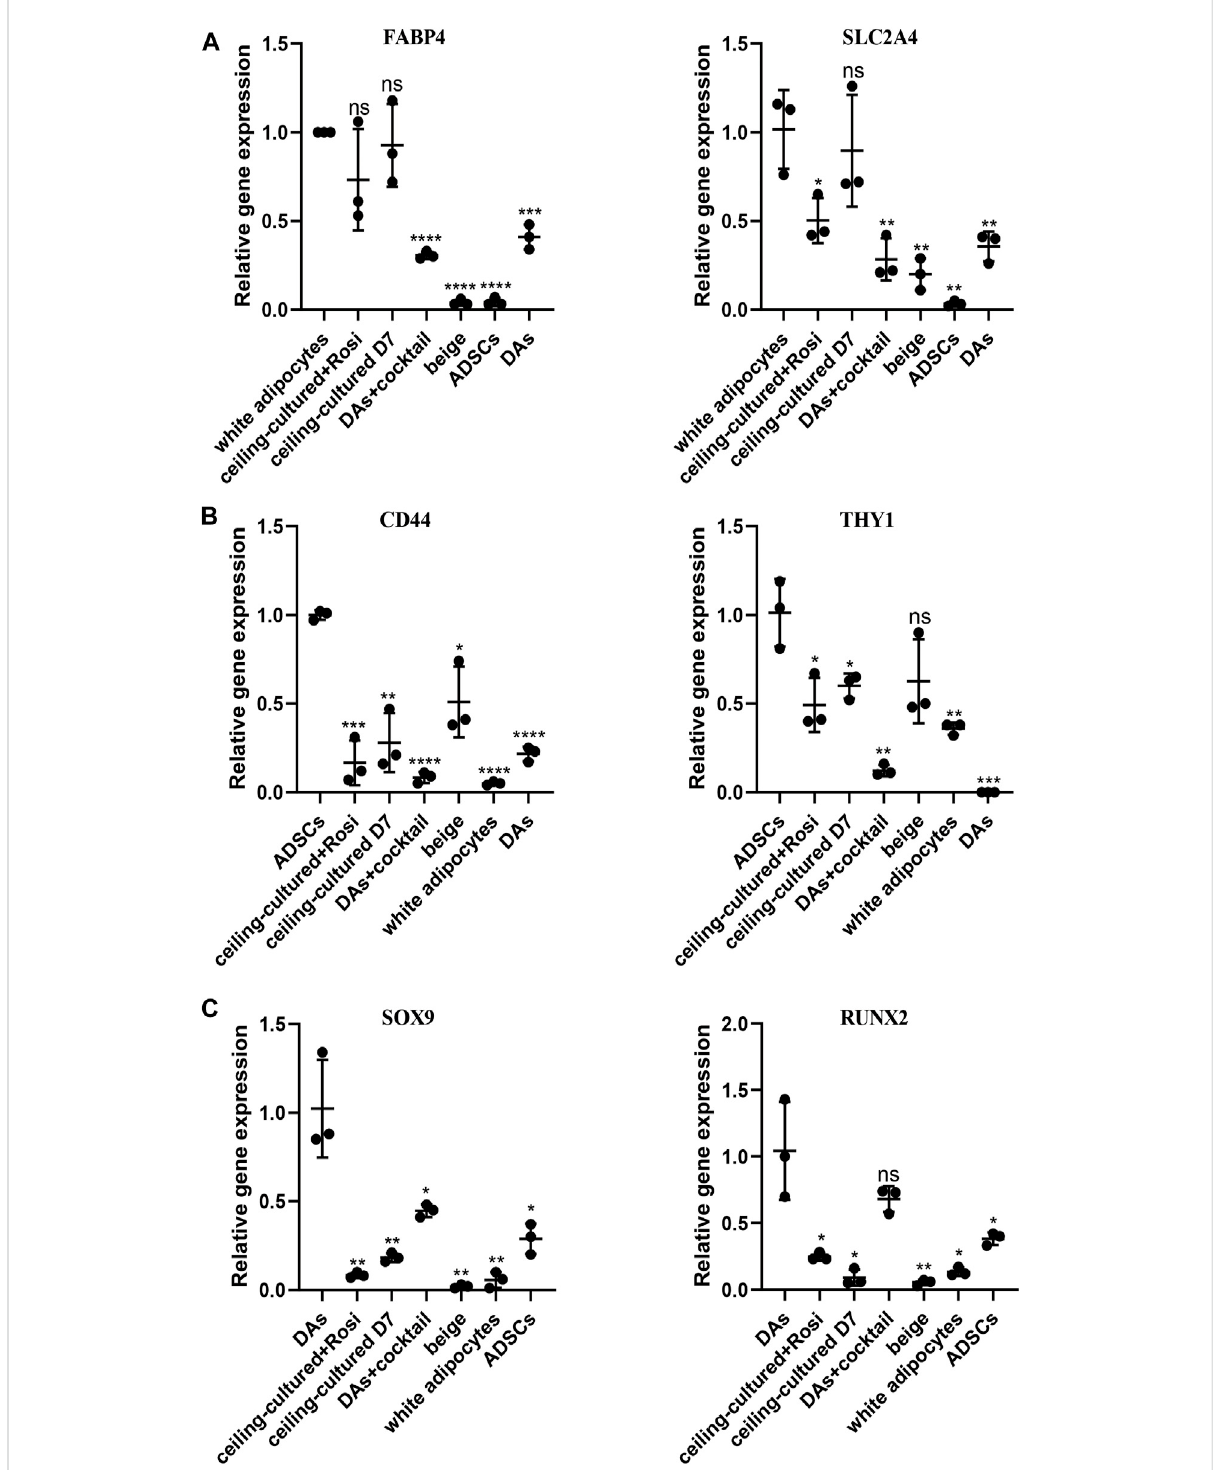
FIGURE 5 Beige adipocytes from different sources identi fi ed by gene expression of cell type-speci fi c markers. (A) Relative gene expression levels of adipocyte-speci fi c genes FABP4 and SLC2A4 , normalized to GAPDH as an endogenous control. (B) Relative gene express of the ADSC-speci fi c markers CD44 and THY1 , normalized to GAPDH as an endogenous control. (C) Dedifferentiated adipocytes ( DAs) gene expression of the mesenchymal lineage-committed markers RUNX2 and SOX9 , normalized to GAPDH as an endogenous control. Data are mean ± SEM ( n = 3). ns, non-signi fi cant. * p < 0.05, ** p < 0.01, *** p <